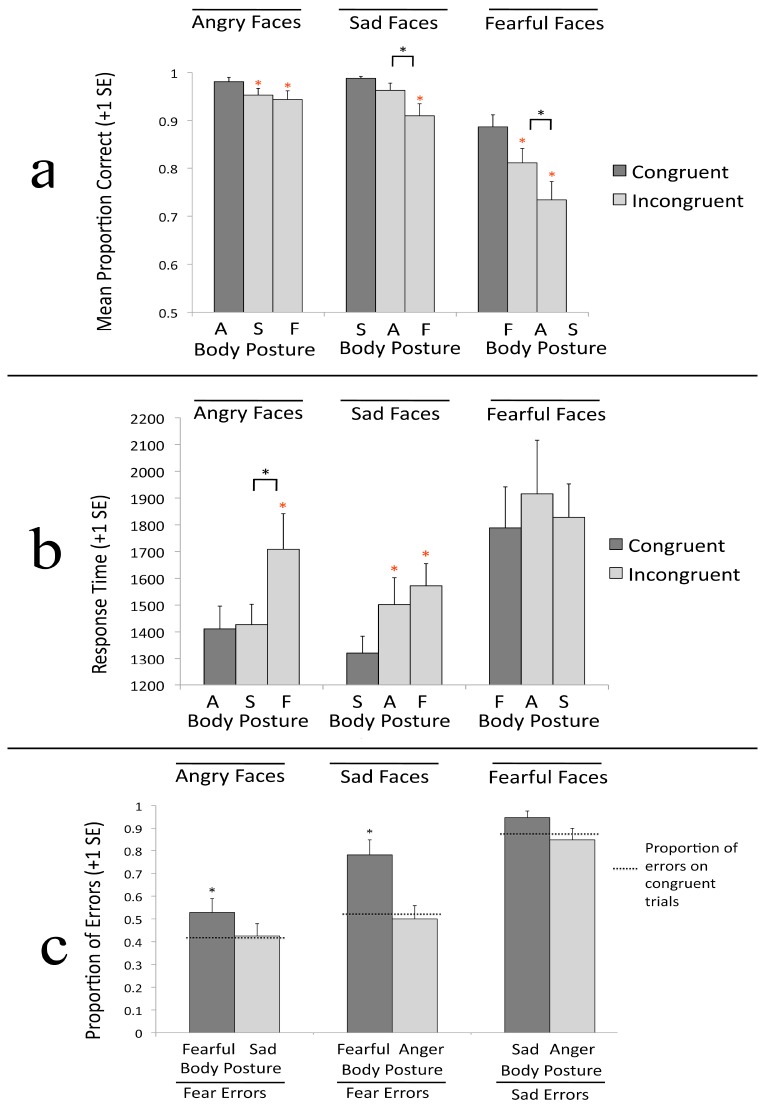
Results for Experiment 1b.a) Proportion of correct responses for each facial expression, presented by posture. b) Median reaction time results for each facial expression, presented by posture. Results are presented in milliseconds. c) Proportion of errors made for each facial expression, presented by posture. Dotted line represents the proportion of errors made by participants viewing congruent expressions, and was used as a baseline error level. * over individual bars indicate a significant difference between congruent and incongruent trials.